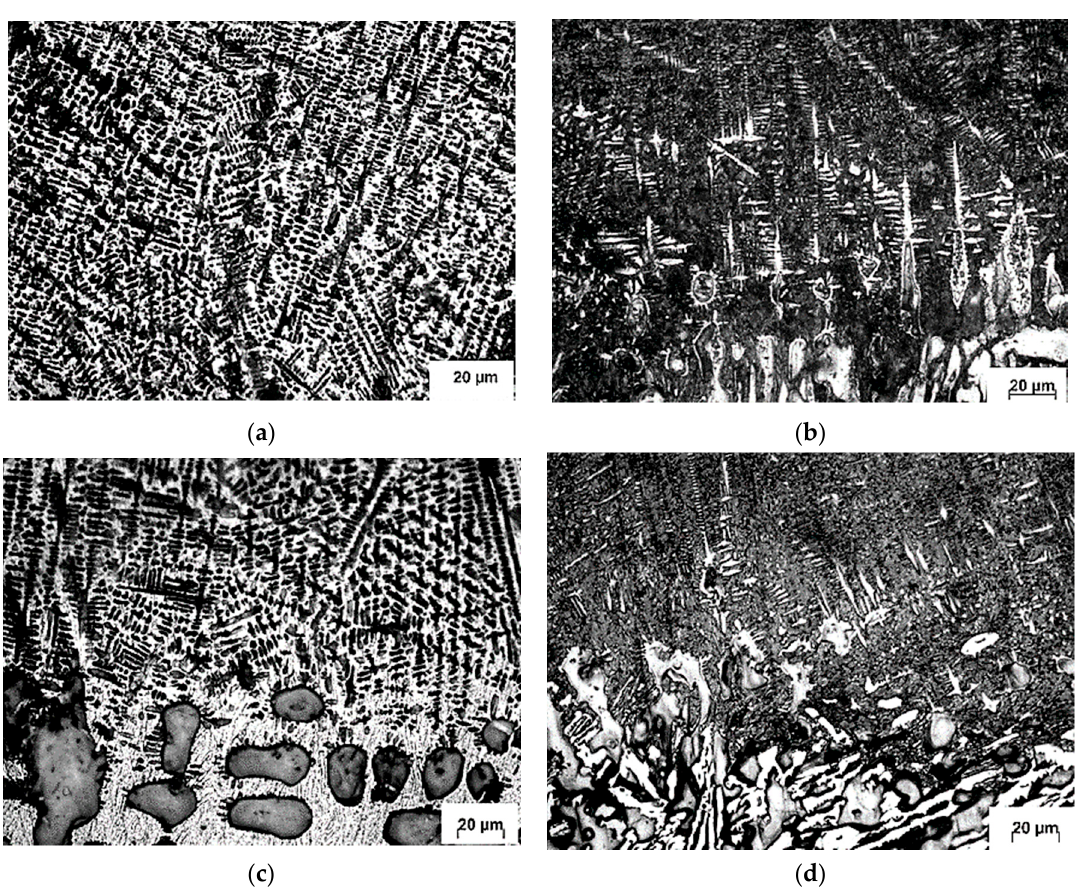
Figure 16. Microstructure of the different martensite morphologies of S1 sample ( a,c ) and S2 sample Figure16. Microstructureofthedi ff erentmartensitemorphologiesofS1sample( a , c )andS2sample( b , d ( b,d ).